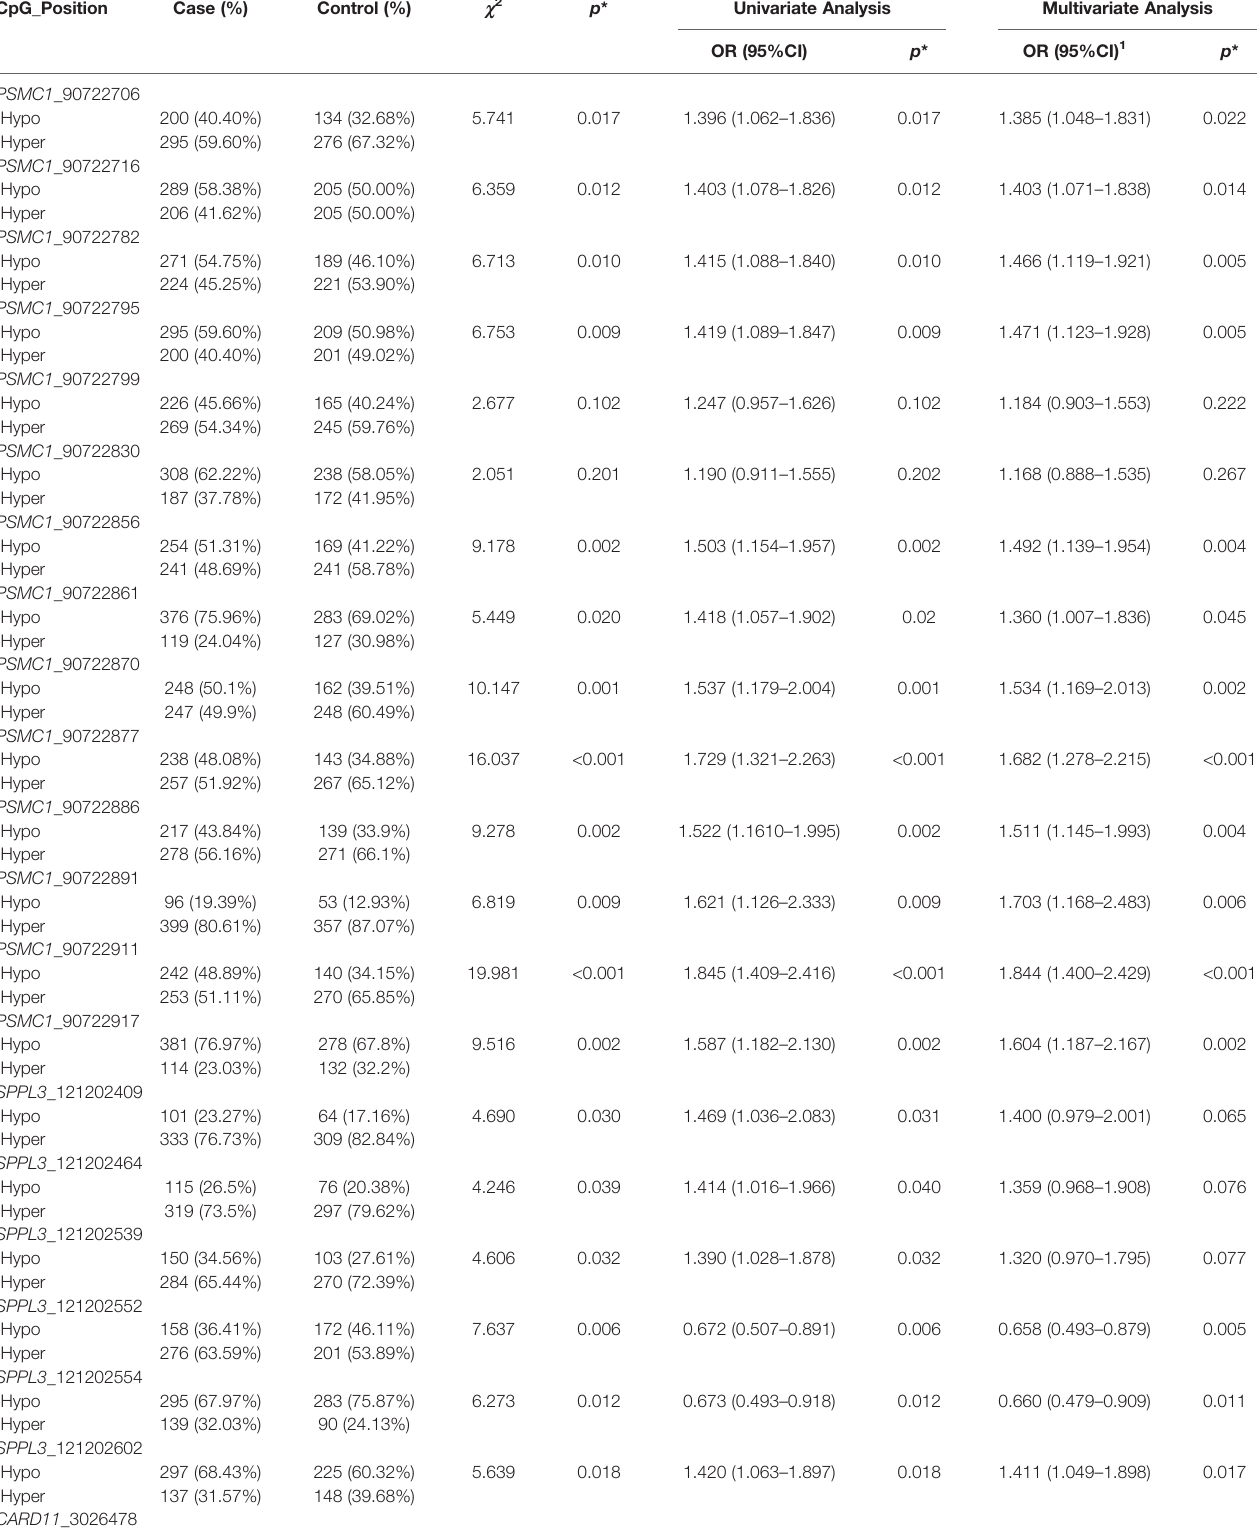
TABLE 3 | The association between methylation of the CpG sites from fi ve genes and the risk of